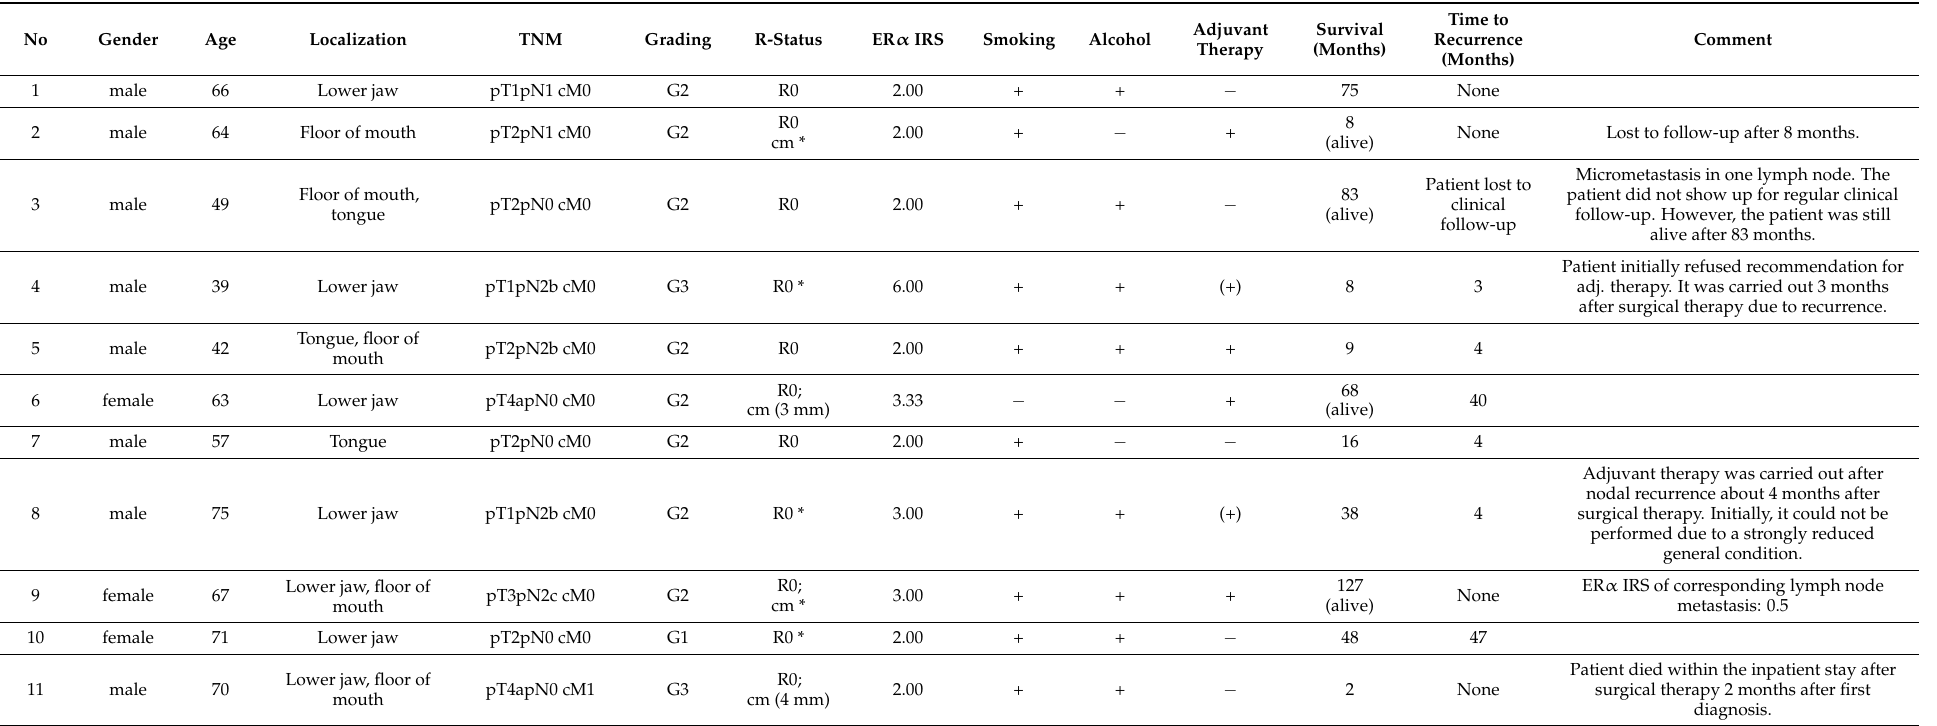
Table 2. Clinicopathological characteristics of all patients with an ER α -positive primary